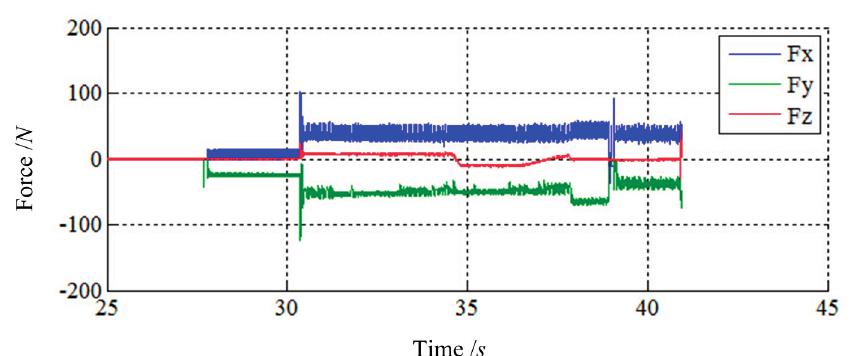
Figure 15. The force tracking results of Case 3.